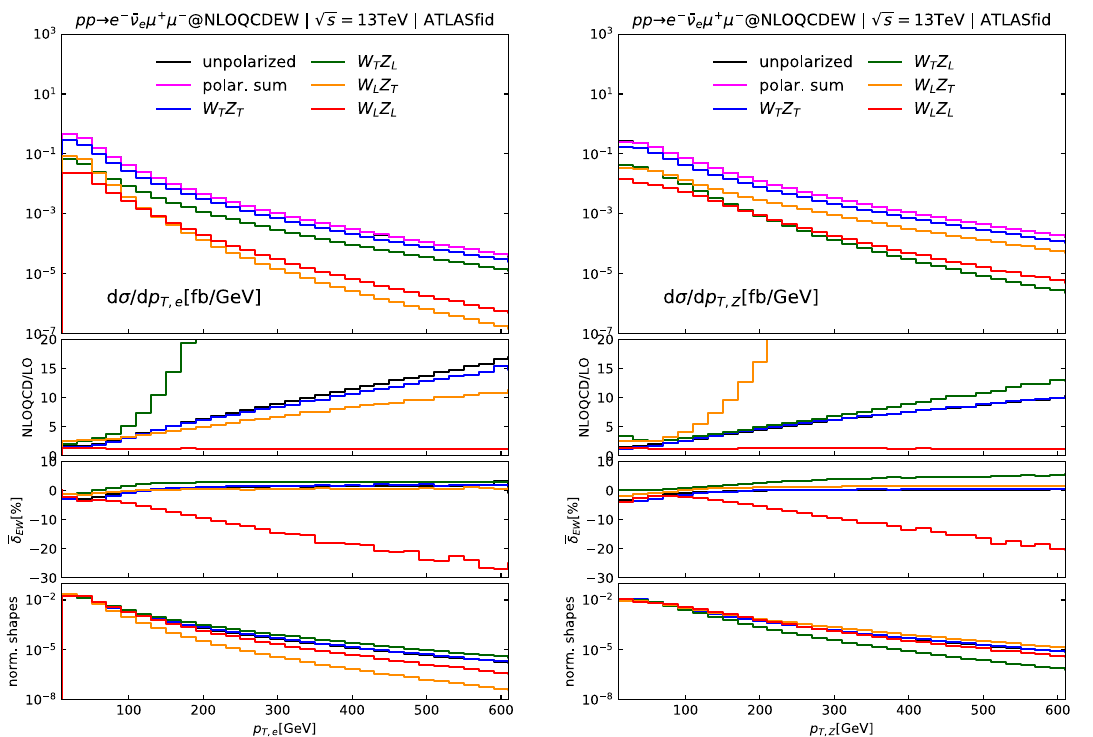
Fig. 4 Same as Fig. 2 but for the transverse momentum of the electron (left) and the Z boson